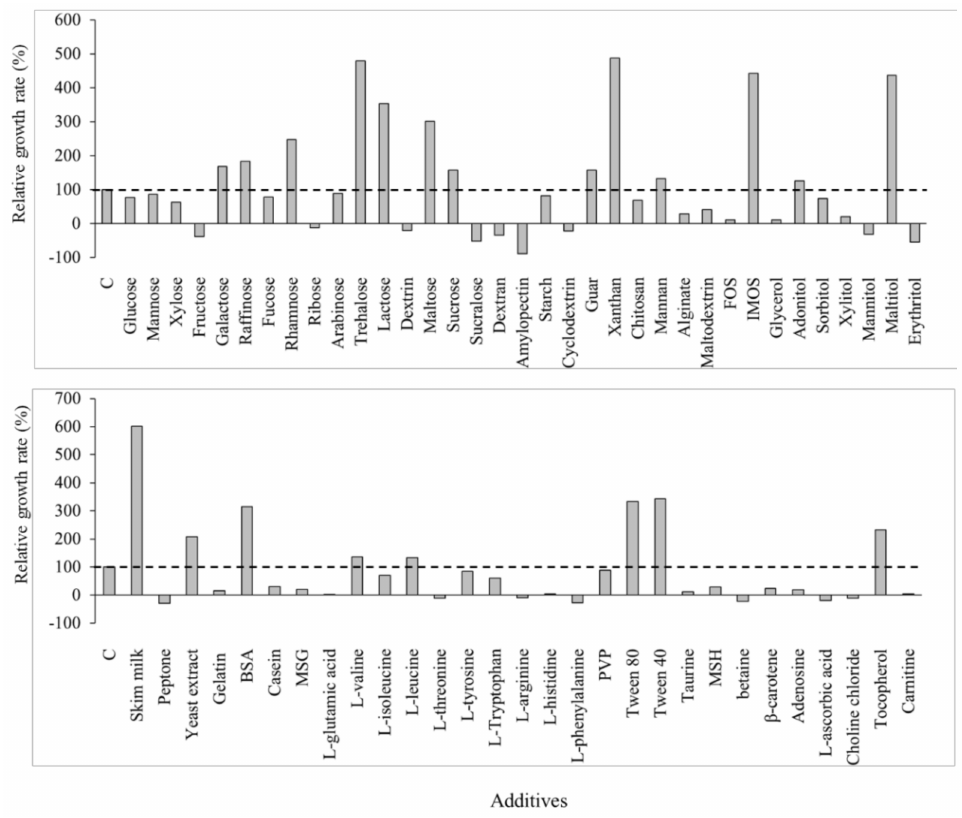
Figure 1. Relative cell growth rate of freeze-dried Saccharomyces cerevisiae 88-4 with various protectant agents. FOS, fructooligosaccharide; IMOS, isomaltooligosaccharide; BSA, bovine serum albumin; MSG, L -glutamic acid monosodium salt hydrate; PVP, polyvinyl pyrrolidone; MSH, magnesium sulfate